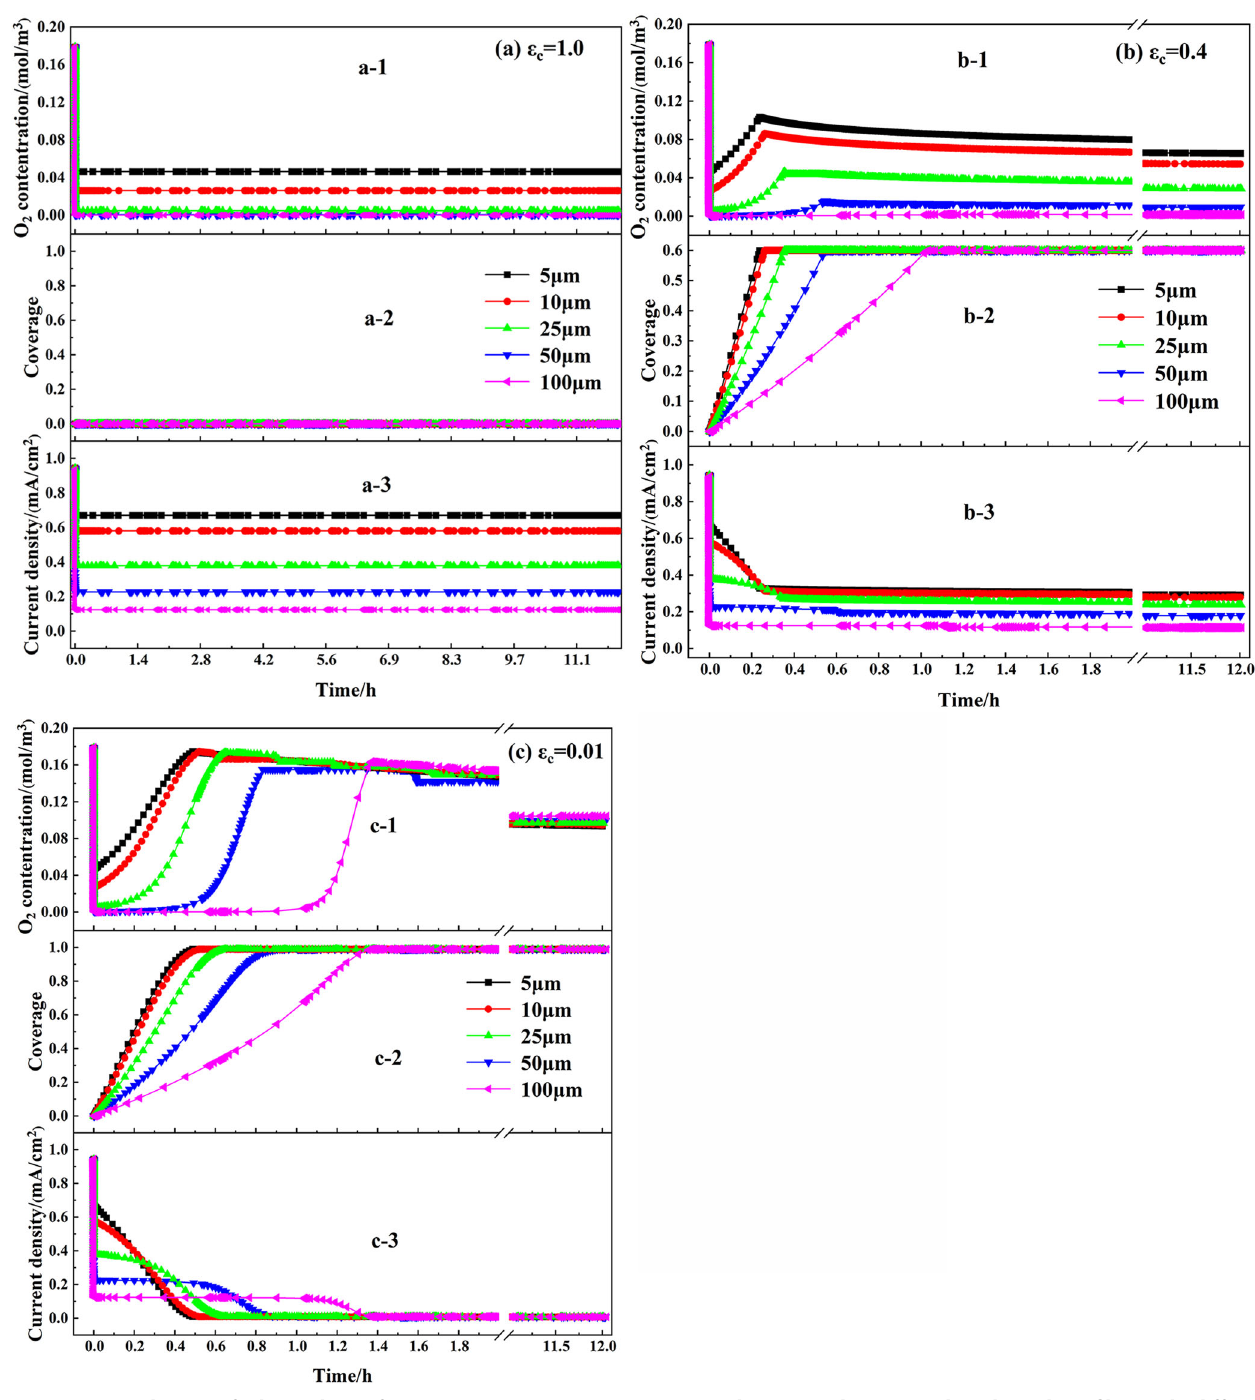
Fig. 5 Time evolution of electrode surface O 2 concentration, coverage and current density under electrolyte fi lm with different thicknesses. a the ε c of corrosion products is 1.0. b the ε c of corrosion products is 0.4. c the ε c of corrosion products is 0.01. 1 electrode surface O 2 concentration. 2 electrode surface coverage. 3 electrode surface current